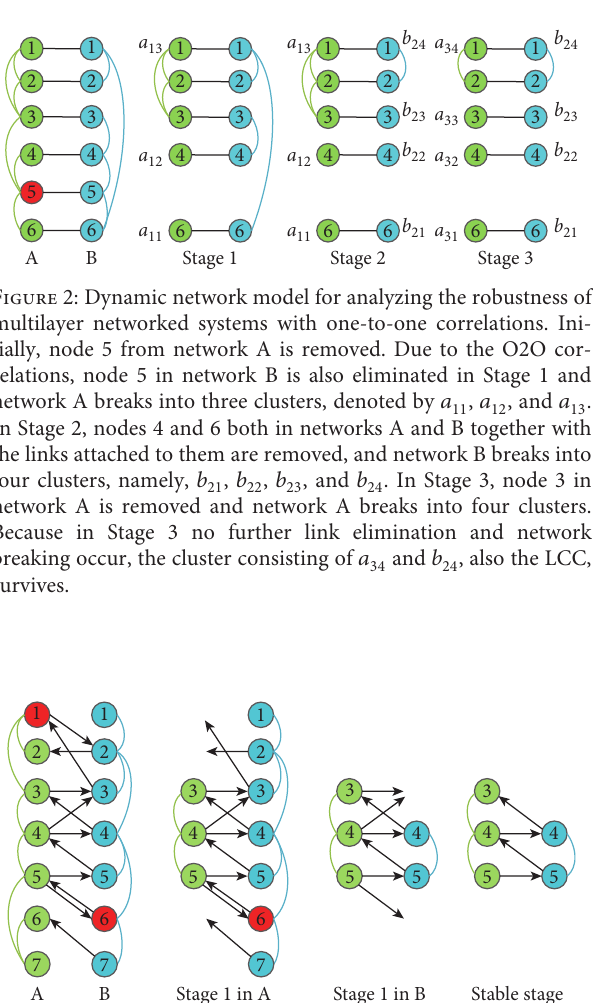
Figure 3: Dynamic network model for analyzing the robustness of multilayer networked systems with one-to-many correlations. Arrows represent the support links connecting a support node in one network to the dependent node in the other network. Initially, the attacks are on node 1 in A and node 6 in B. For network A in Stage 1, node 7 fails because it has no support links, and nodes 2 and 6 are eliminated because they do not belong to the LCC of A. For network B in Stage 1, nodes 1, 2, and 7 fail because of no support, and node 3 is removed since it is not in the LCC of B. The above processes continue until a stable state is reached.